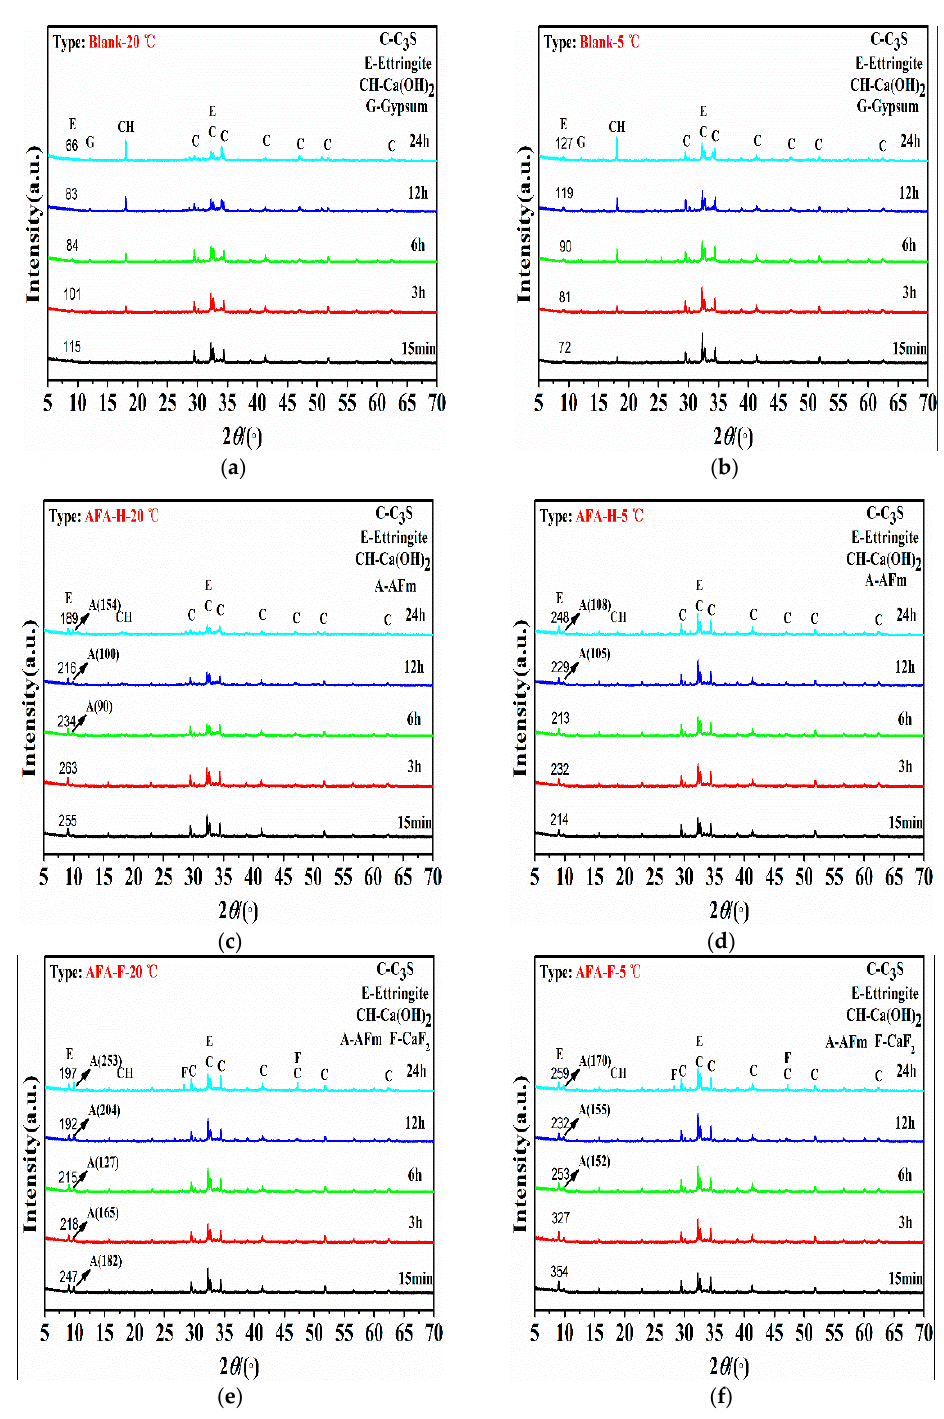
Figure 3. Evolution of XRD patterns in the cement paste with reference ( a , b ), non-fluorine alkali-free setting accelerators ( c , d ), and fluorine-containing alkali-free setting accelerators ( e , f ) during the first 24 h of hydration under 20 °C or 5 °C environment temperatures. ( a ) XRD patterns of the reference paste - at 20 °C, ( b ) XRD patterns of the reference paste at 5 °C, ( c ) XRD patterns of the AFA-H paste - at 20 °C, ( d ) XRD patterns of the AFA-H paste at 5 °C, ( e ) XRD patterns of the AFA-F paste - at 20 °C, ( f ) XRD patterns of the AFA-F paste at 5 °C.